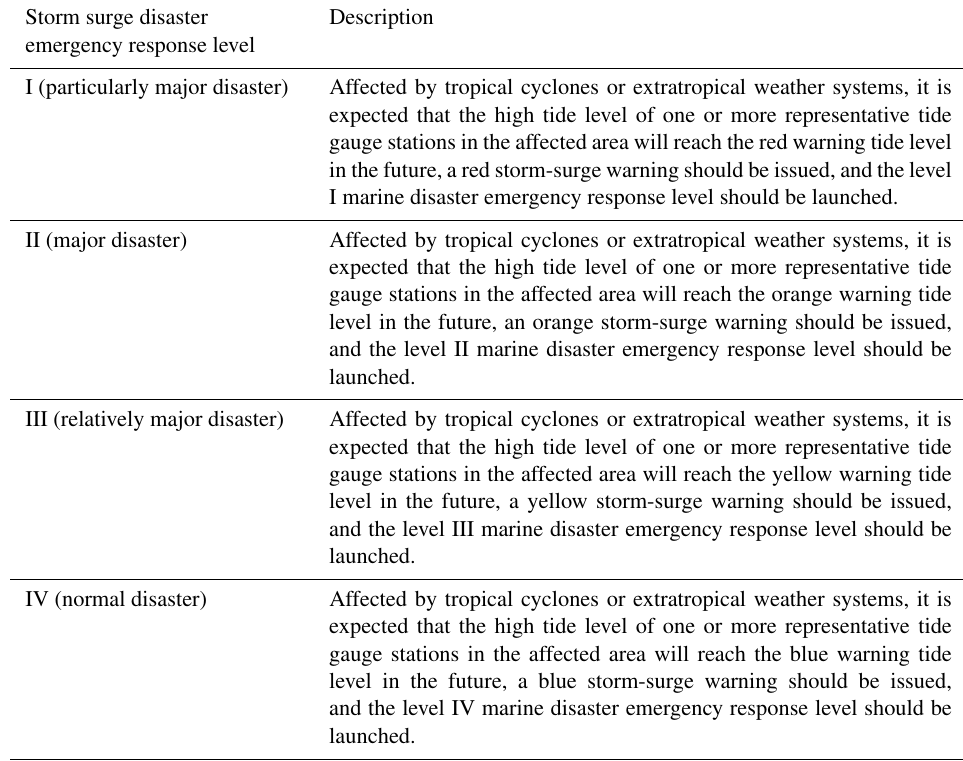
Table 2. Description of the storm-surge disaster emergency response